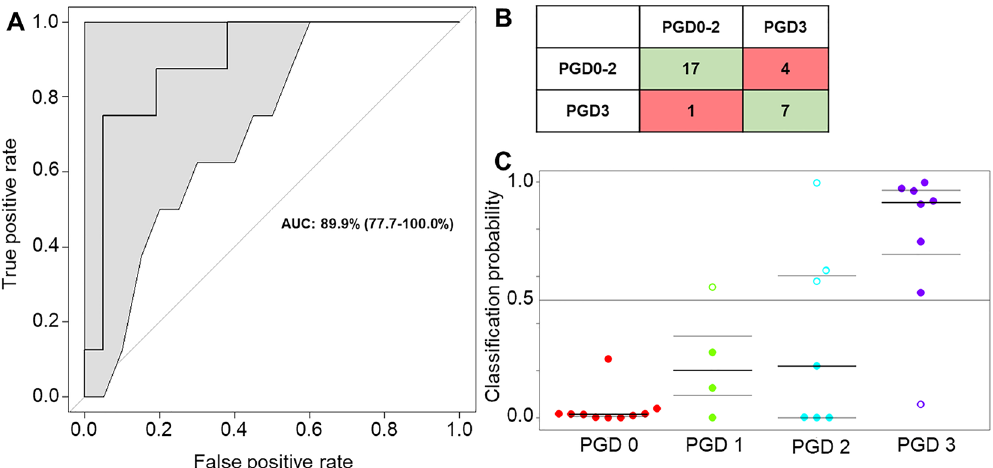
Figure 3. ( A ) Receiver operating characteristic (ROC) curve with 95% confidence interval (grey shape) on the test set. ( B ) Confusion matrix for the test set on the selected features model. The green boxes correspond to correct classification, the red ones to misclassification. ( C ) Classification probability according to the clinical PGD. The filled dots correspond to correct classification, the empty ones to misclassification. Figures of merit are provided in Table